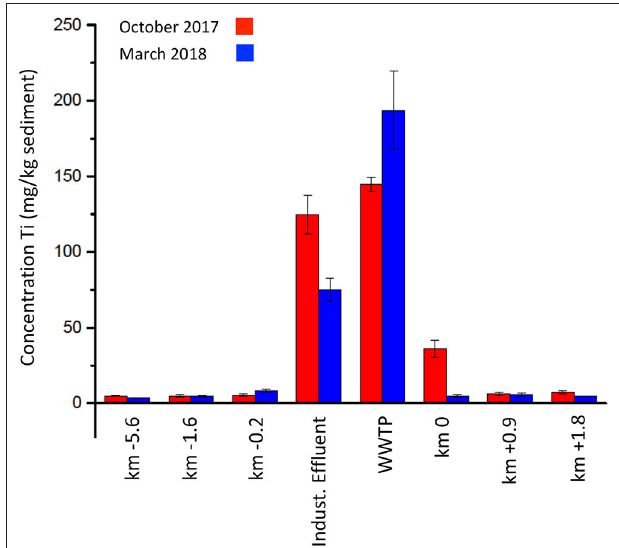
FIGURE 2 | Sediment ( < 250 µ m) Ti concentrations (mg Ti/kg sediment) at each sampling site for October 2017 and March 2018. Error bars represent replicate sample digestions of the same sample ( n =